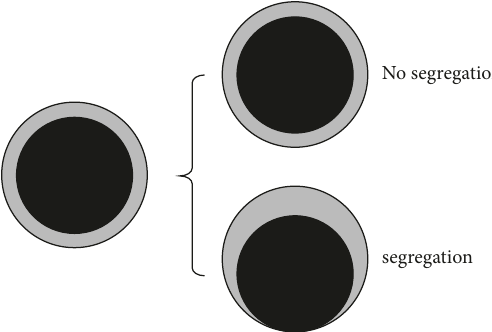
Figure 2: Schematic diagram of slurry segregation.